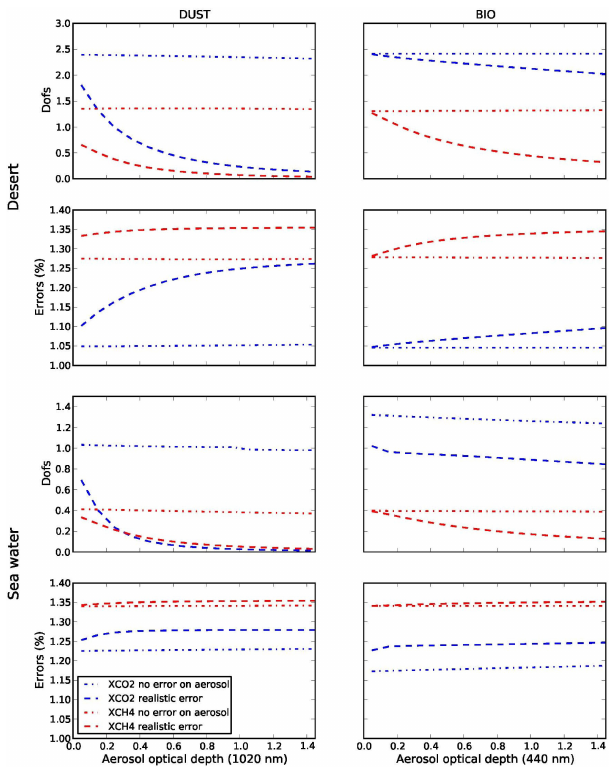
Fig. 2. Gaseous column DOFSs and errors (in %) vs. AOD. CO 2 is in blue lines and CH 4 is in red lines. Case 1 and Case 2 are dotted and dashed lines,